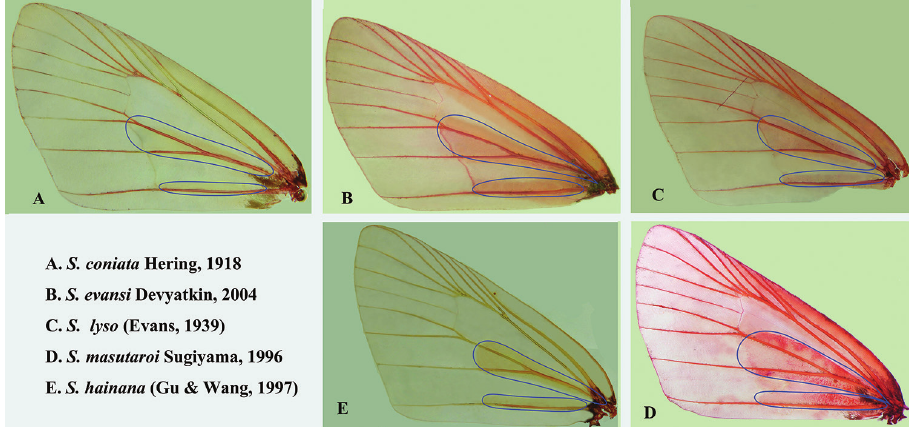
Figure 2. Male band of scent scales in the S. coniata group